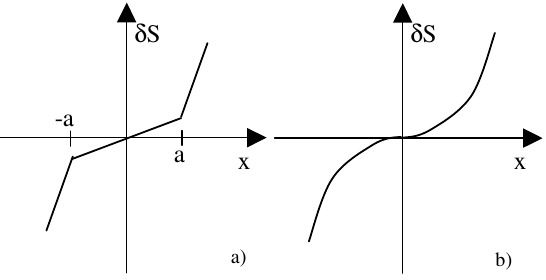
Fig 4. Sample forming functions bringing non-linear relation position of control surfaces from side stick’s